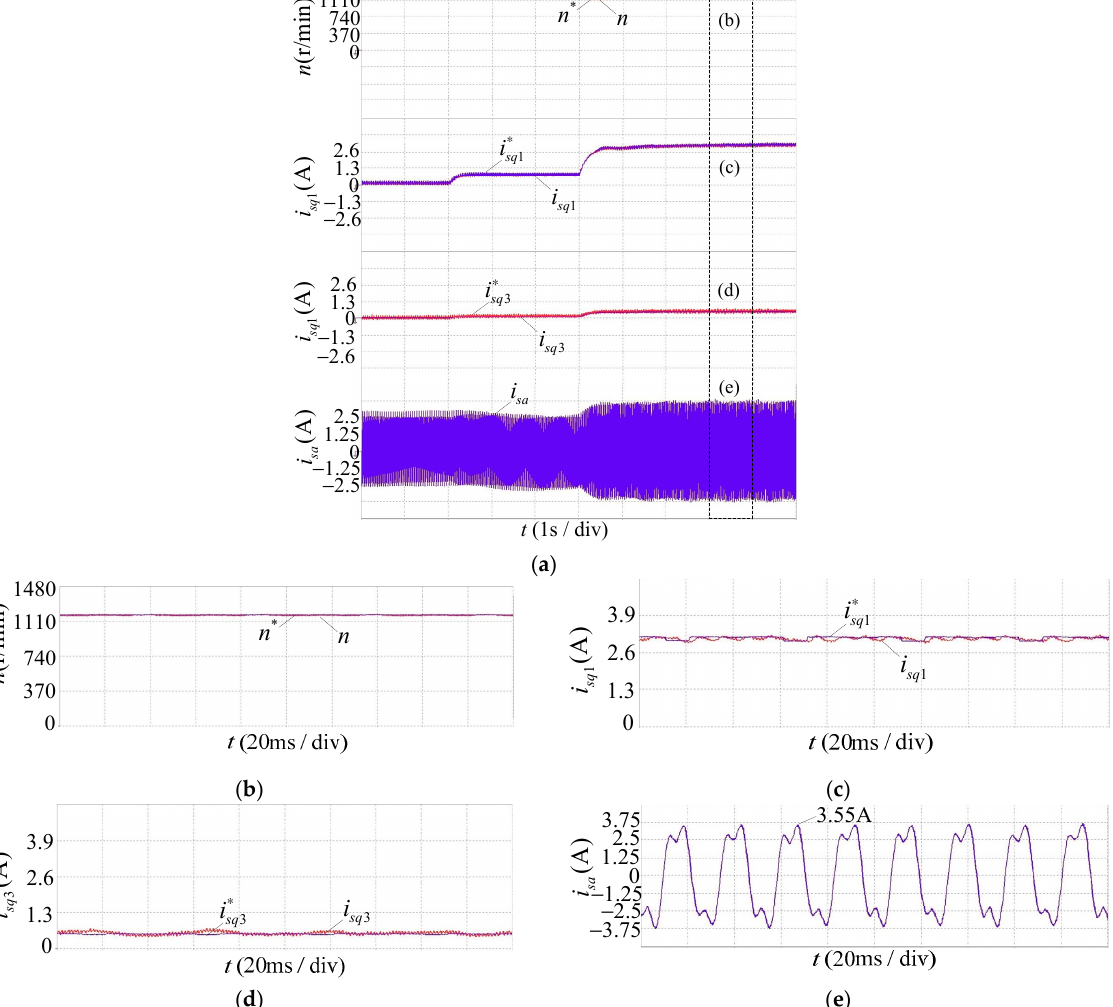
Figure 6. Experimental waveform of the MPC + FOC system at 1200 r/min, showing ( a ) the whole process; ( b ) the speed n ; ( c ) the current i sq 1 ; ( d ) the current i sq 3 ; and ( e ) the current i sa